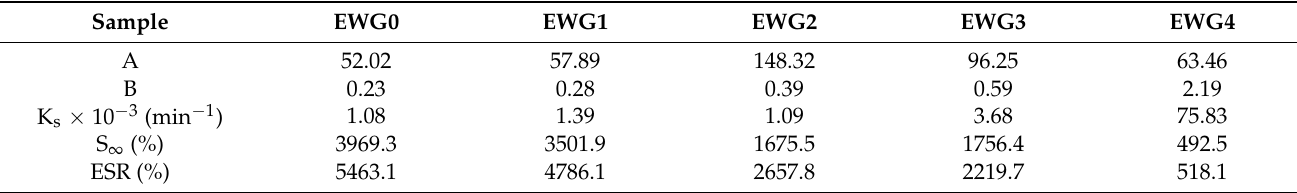
Table 2. Second-order kinetic parameters for hydrogels.